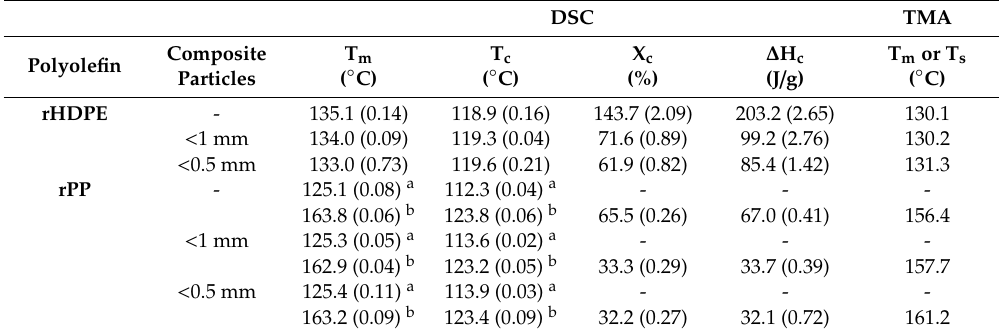
Note: Standard deviations are in parentheses. a minor peaks and b major